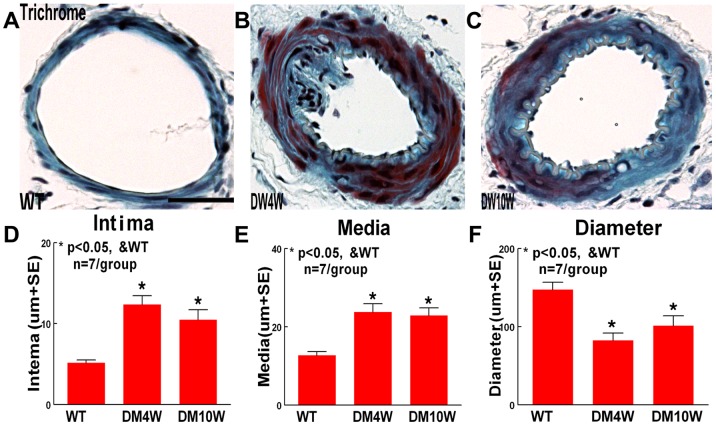
T1DM accelerates arteriosclerosis-like changes in ICA.A–C: Trichrome staining in WT (A), 4 week T1DM (B) and 10 week T1DM (C) rats. D–F: Quantitative data. T1DM increases the ICA intimae (D) and media thickness (E), and decreased the ICA diameter (F) (p<0.05). Scale bar in A, 0.1 mm.